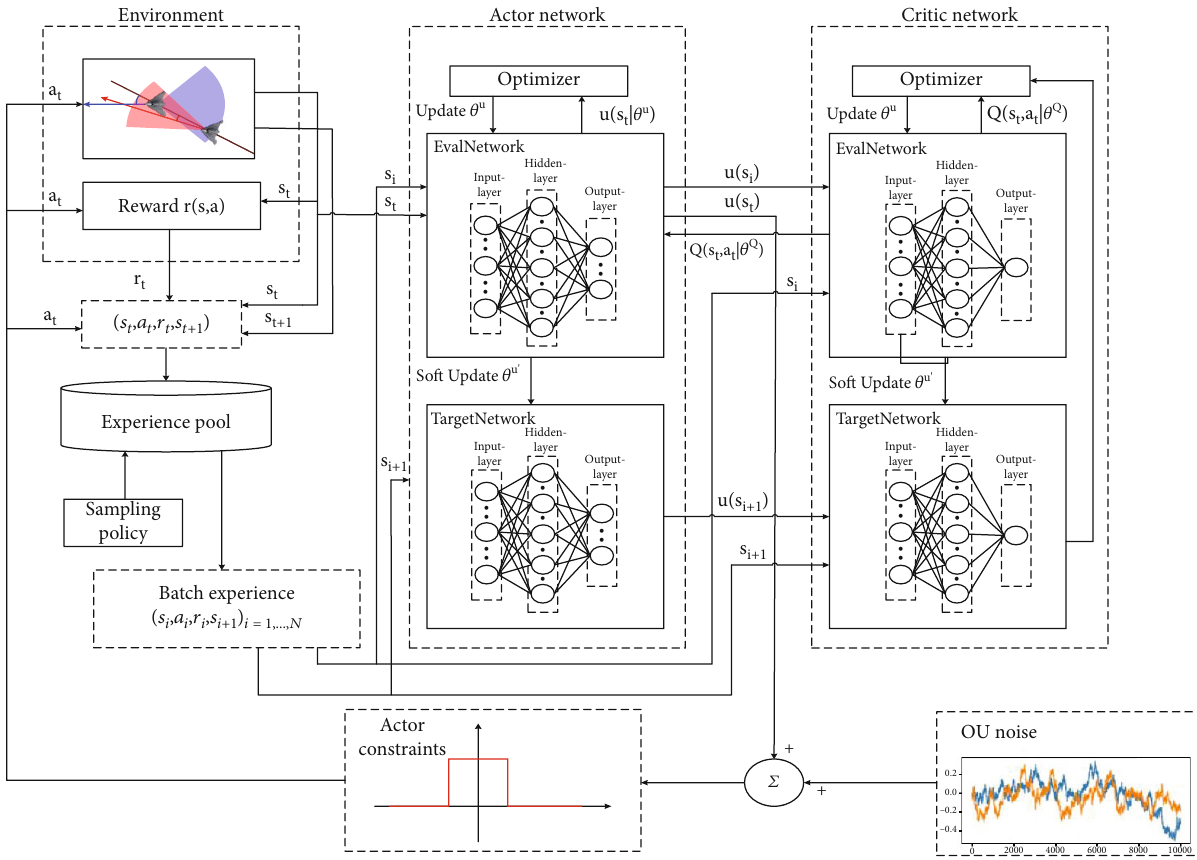
Figure 2: DDPG network